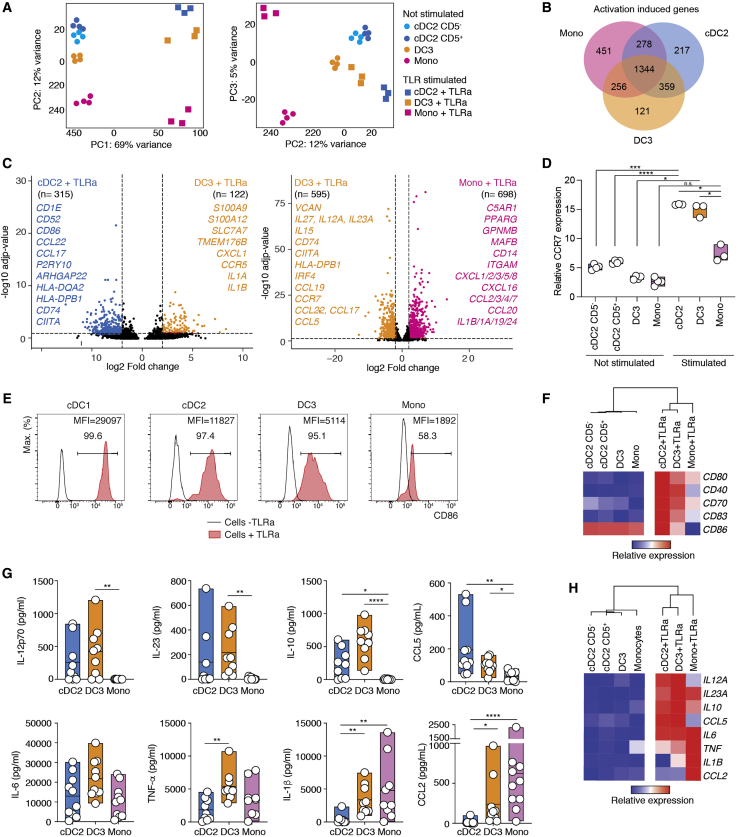
DC3s Respond to TLR StimulationWe performed bulk RNA-seq analysis of BTLA+CD5+ and BTLA+CD5− cDC2s, DC3s, and monocytes sorted as shown in Figure 1H and stimulated overnight (16 h, 3 donors) or not (4 donors) with a TLR agonist cocktail (25 μg/mL poly(I:C), 1 μg/mL R848, and 10 ng/mL LPS). For activation of cDC2s, BTLA+CD5+ and BTLA+CD5− were pooled.(A) PCA analysis for all genes.(B) Venn diagram summarizing the number of activation-induced DEGs upregulated in stimulated compared with unstimulated cells within each cell population.(C) Volcano plots showing DEGs between TLR agonist-stimulated DC3s compared with TLR agonist-stimulated cDC2s or TLR agonist-stimulated monocytes. Genes with Log2(FC) > ±2 and a FDR-adjusted p value of less than 0.05 were considered significant.(D) Bar graph summarizing relative CCR7 gene expression within TLR-agonist stimulated or unstimulated mononuclear phagocyte populations (n = 3–4; a line represents the median; ∗p < 0.05, ∗∗p < 0.01, ∗∗∗p < 0.001, ∗∗∗∗p < 0.0001, one-way ANOVA test).(E) Histograms showing the frequency and median of fluorescence intensity (MFI) of CD86 on TLR agonist-stimulated or unstimulated mononuclear phagocyte populations.(F) Heatmap showing the relative gene expression of selected costimulatory molecules on TLR agonist-stimulated or unstimulated mononuclear phagocyte populations.(G) Quantification of cytokines and chemokines secreted by cDC2s, DC3s, and CD14+ monocytes in response to overnight stimulation with a cocktail of TLR agonists (n = 9 healthy donors; a line represents the median; ∗p < 0.05, ∗∗p < 0,01, ∗∗∗∗p < 0,0001, one-way ANOVA test).(H) Heatmap showing the relative gene expression of cytokines and chemokines analyzed in (G) within TLR-agonist stimulated or unstimulated mononuclear phagocyte populations.See also Figure S6 and Table S1.